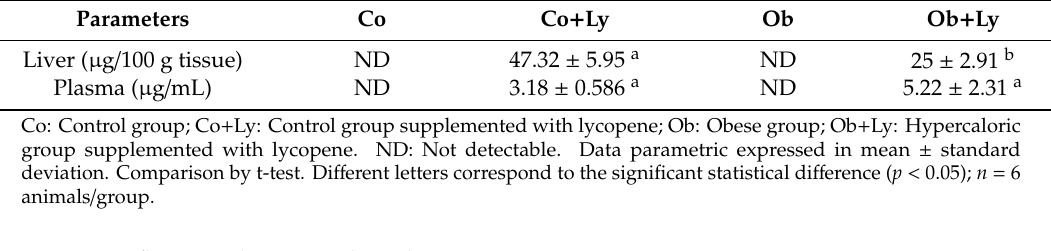
Table 3. Markers for clinical biochemistry.